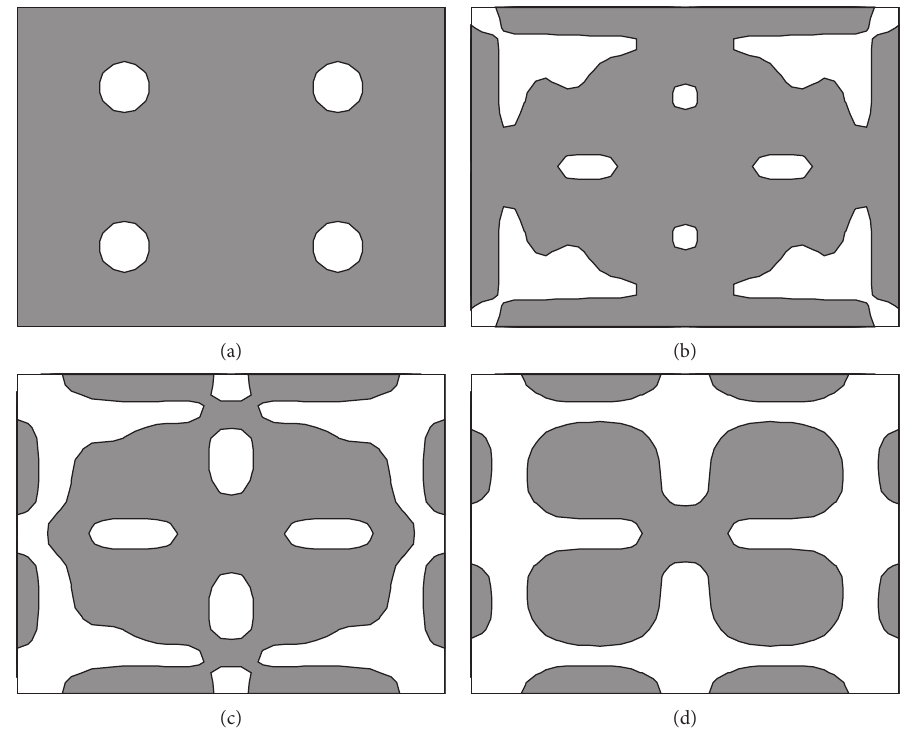
Figure 6: Evolution history of the optimized design of the damping layer for the 5th modal with four holes as the initial design. (a) Step 1. (b) Step 15. (c) Step 25. (d) Step 81.